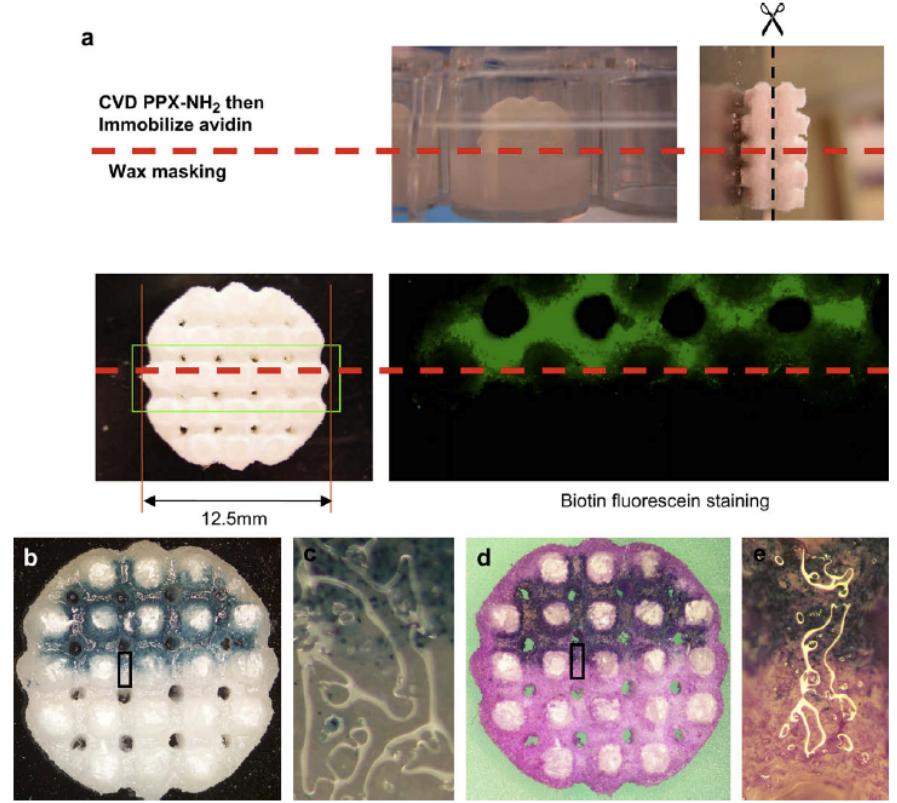
Figure 16. Spatial control of adenovirus immobilization in 3-D scaffolds. Reprinted from reference [72]. Copyright (2009), with permission from